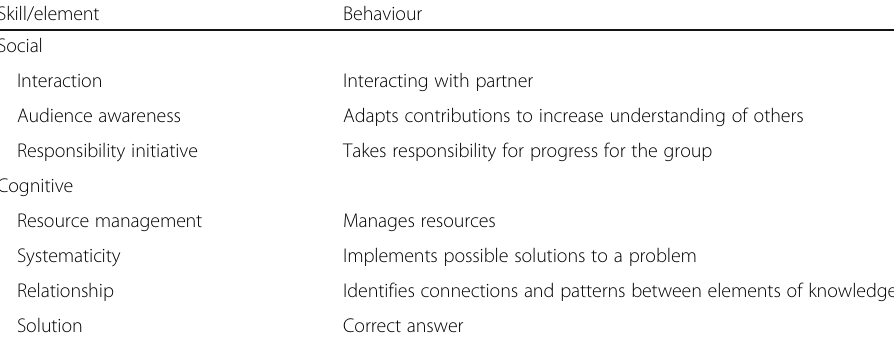
Table 5 The categorisation matrix of the behavioural indicators of CPS elements in the Laughing Clowns